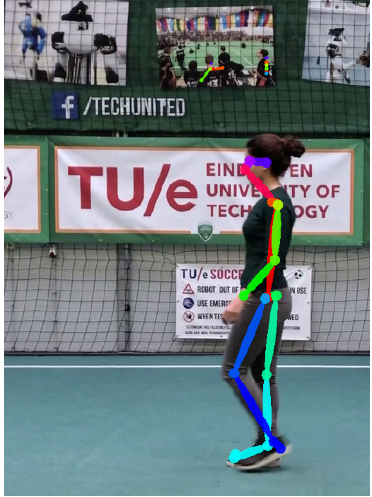
Figure 8. A pedestrian is crossing in front of a camera with constant